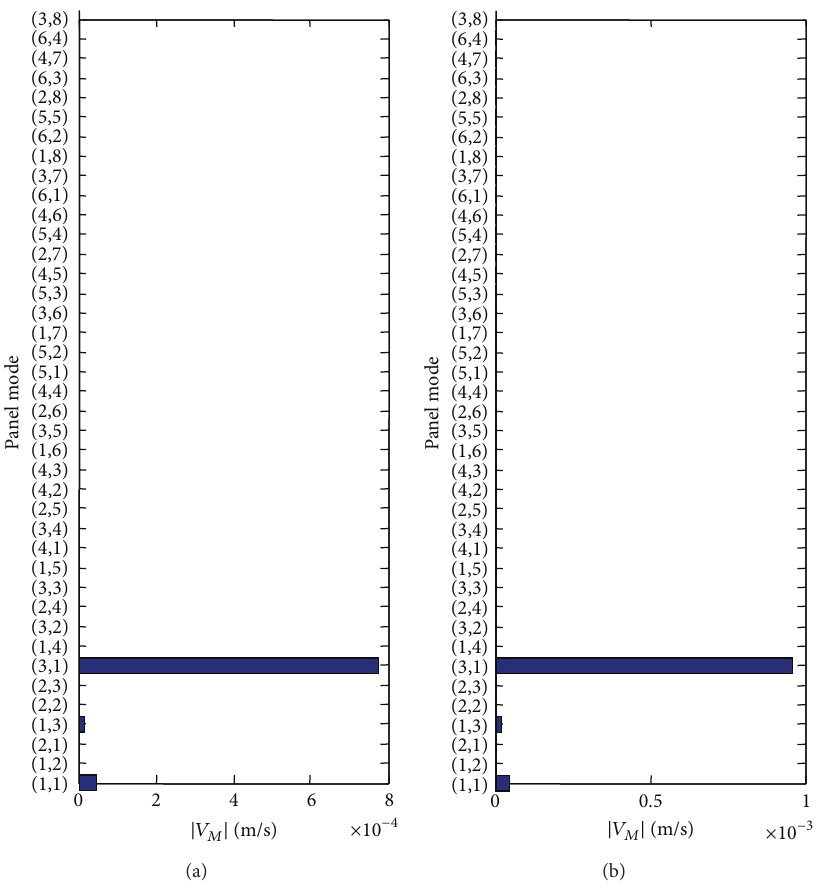
Figure 5: Modal amplitude of the panel vibration velocity: (a) the (0,0,1) enclosure-controlled mode; (b) the (3,1) panel-controlled mode. = 0.6 m, 𝑇 = 15 s, 𝑇 = 0.5 s. ℎ = 0.00844 m, 𝐿 𝑍 𝑎𝑁 𝑝𝑀